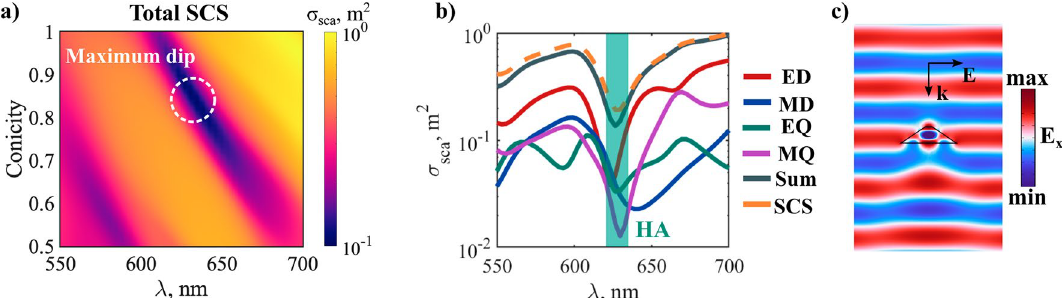
Figure 8. ( a ) Evolution of the total SCS near the HA for cone. The white-dashed circle highlights the region with the strongest scattering suppression in the parameter range considered. ( b ) Multipole decomposition of the SCS for a truncated nanocone with conicity 0.88, lying within the region of maximum scattering suppression shown in ( a ). The green-shaded area indicates the spectral range with the maximum scattering suppression (approximately 8 times less than the average SCS in the visible). ( c ) x-component of the electric field when illuminating the nanocone with an x-polarized plane wave at a wavelength of 625 nm, corresponding to the HA. The geometrical parameters can be found in section S3 of the Supplementary Information. The experimental dispersion data for a-Si is shown in Supplementary Fig.